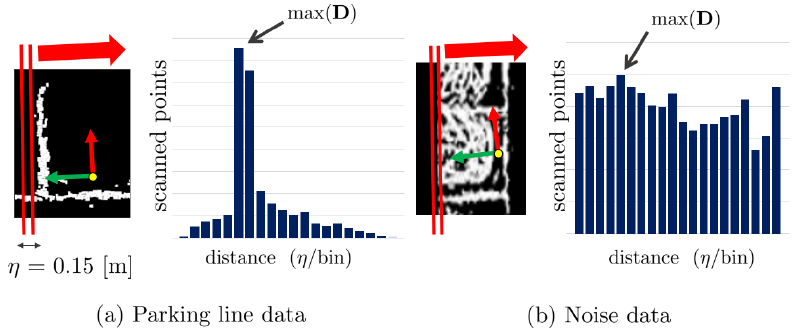
Figure 6. Process of extracting parking line features. The histogram illustrates the data distribution in the vertical direction of the main axis (red arrow). ( a ) Histogram distribution of parking line data. ( b ) Histogram distribution of data with noise. For ( b ), the parking line feature is not